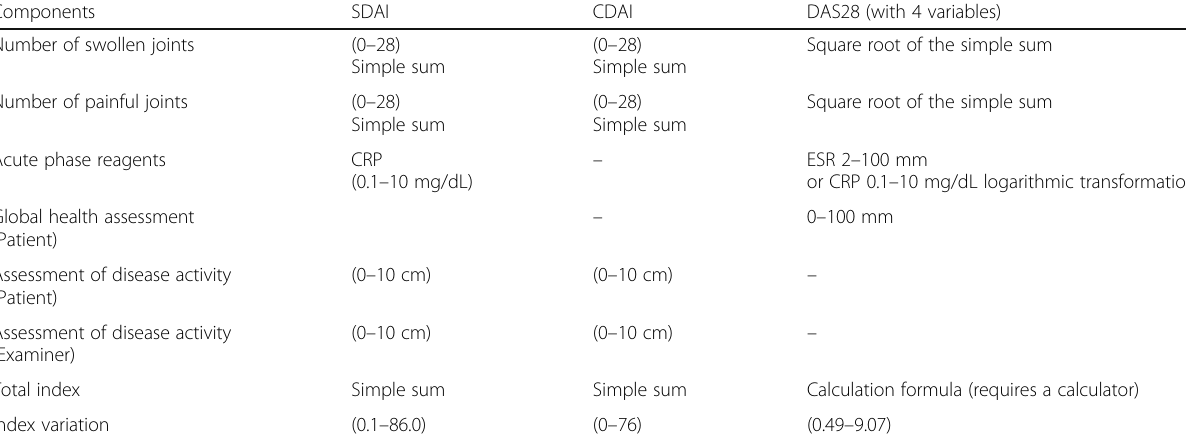
Table 4 Composite measures of disease activity used in rheumatoid arthritis: components, calculation formula, and range of results